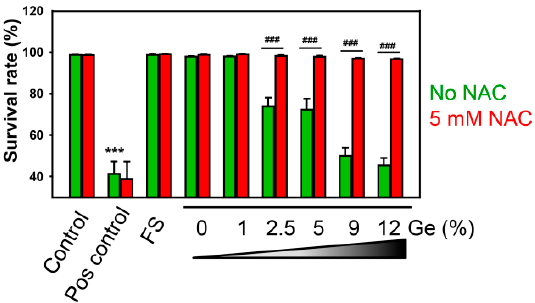
Figure 7. Treatment with ROS scavenging agent N -acetyl-L-cysteine (NAC) completely abolished the cytotoxicity of Ge substrates. Huh7 cells were grown on different Ge substrates for 5 days. To inhibit ROS accumulation, Huh7 were supplemented with 5 mM NAC. Cells were stained with propidium iodide to assess cell viability. The nuclei were counterstained with Hoechst blue. Afterward, cells were imaged using epifluorescent microscope IM-2FL (OPTIKA Italy), and quantitative analysis of survival rate of cells was then done using ImageJ software (NIH). One-way ANOVA with Newman–Keuls multiple comparison test was used. Data are expressed as means ± SEM (n = 3), *** p < 0.001. As a positive control, cells were treated with 20% ethanol for 60 min.